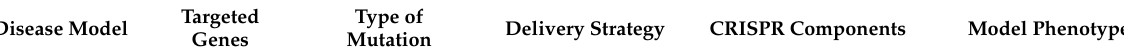
Table 2. CRISPR/Cas9 genome editing in atherosclerosis models (in